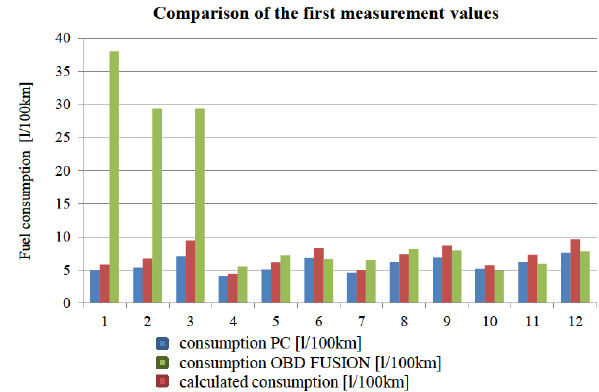
Figure 1: Comparison of the first measurement values